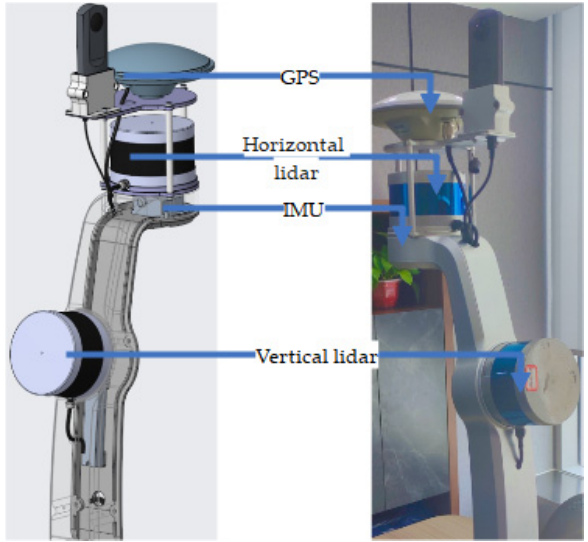
Figure 1. A CAD (Computer Aided Design) model of the scanning arm is shown on the left, with a photograph of the scanning arm shown on the right.